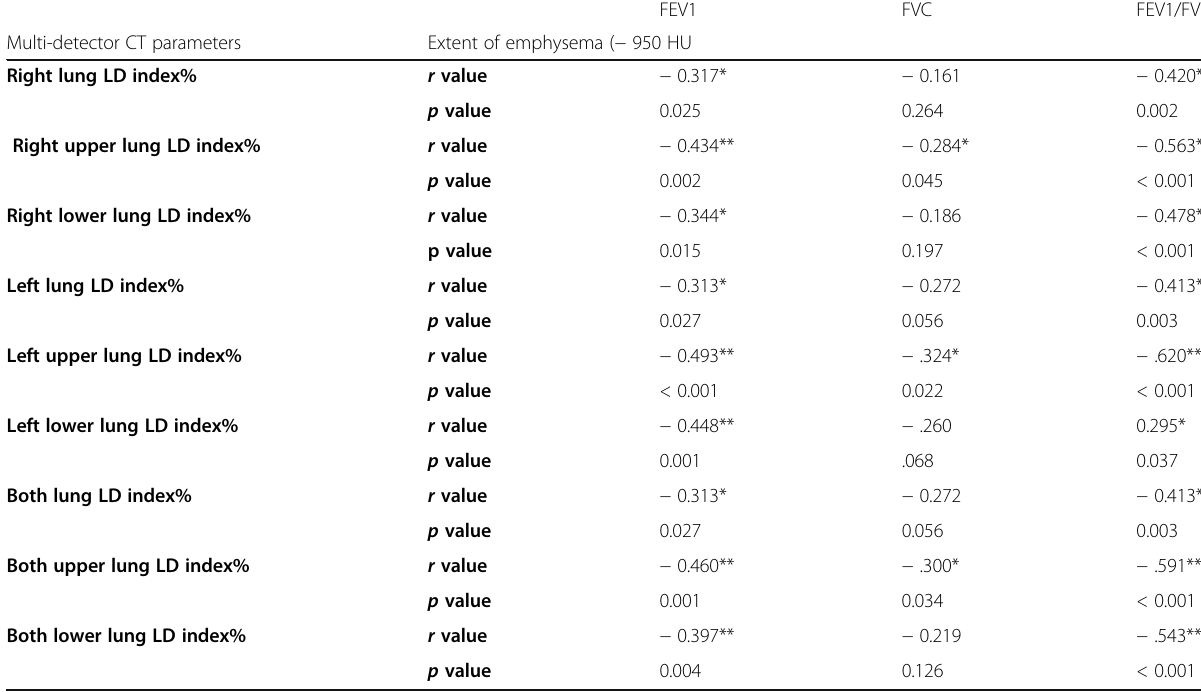
Table 1 Correlation between the pulmonary function tests and extent of emphysema (%LA) below − 950 HU